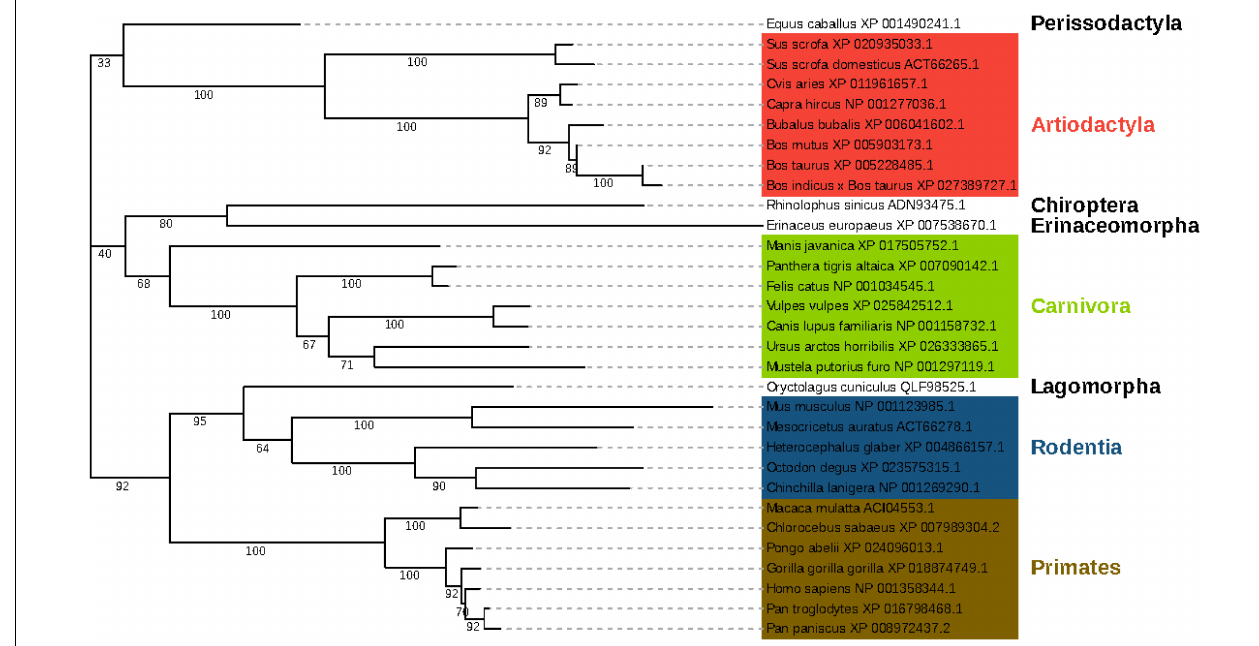
FIGURE 2 | Phylogenetic tree of 31 species based on their ACE2 protein sequences. The branch length represents the number of substitutions per site, with the positions containing gaps and missing data being eliminated. The tree was clustered into 4 main orders, namely Primates , Rodentia , Artiodactyla, and Carnivora, respectively. Primates were marked in the red frame; Rodentia was in the blue frame; Artiodactyla was in the green frame, and Carnivora was in the purple